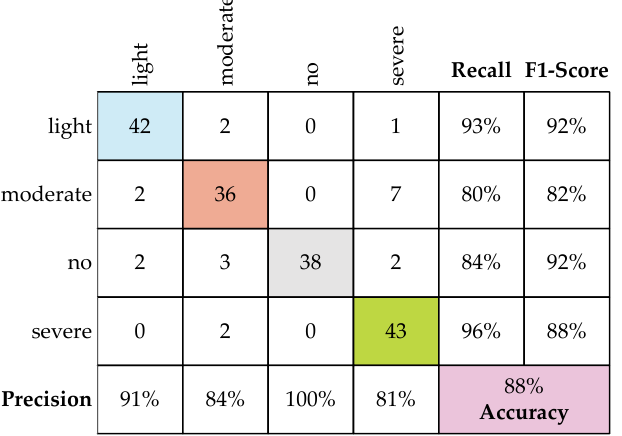
Figure 10. Confusion matrix for the fine-tuned MobileNet CNN model.